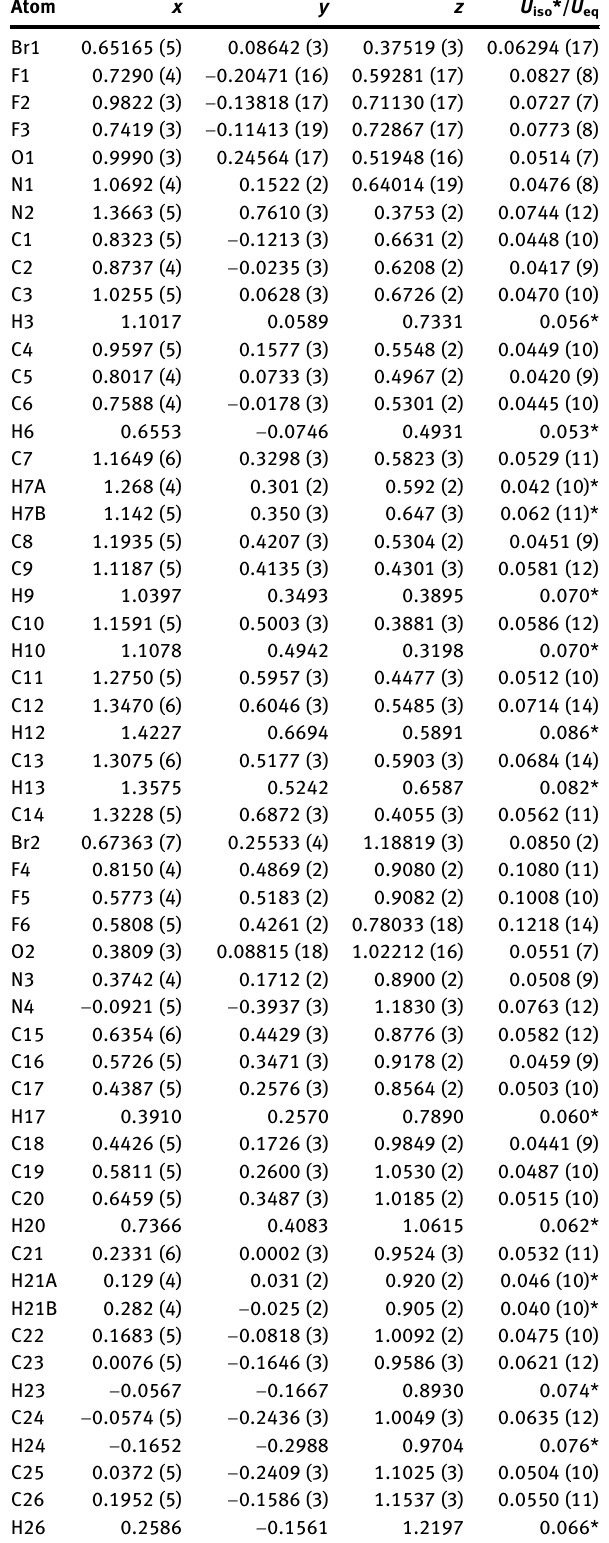
Table  : Fractional atomic coordinates and isotropic or equivalent isotropic displacement parameters (Å 